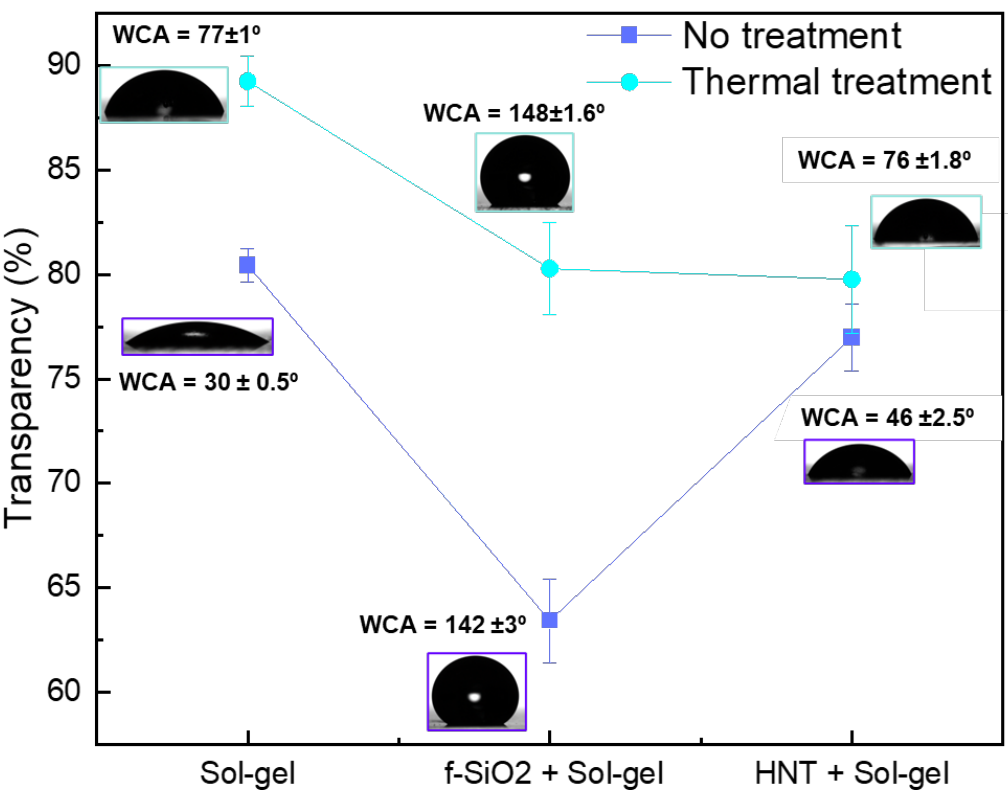
Figure 3. Coatings ’ transmittance and WCA images without and with thermal treatment. Figure 3. Coatings’ transmittance and WCA images without and with thermal treatment.